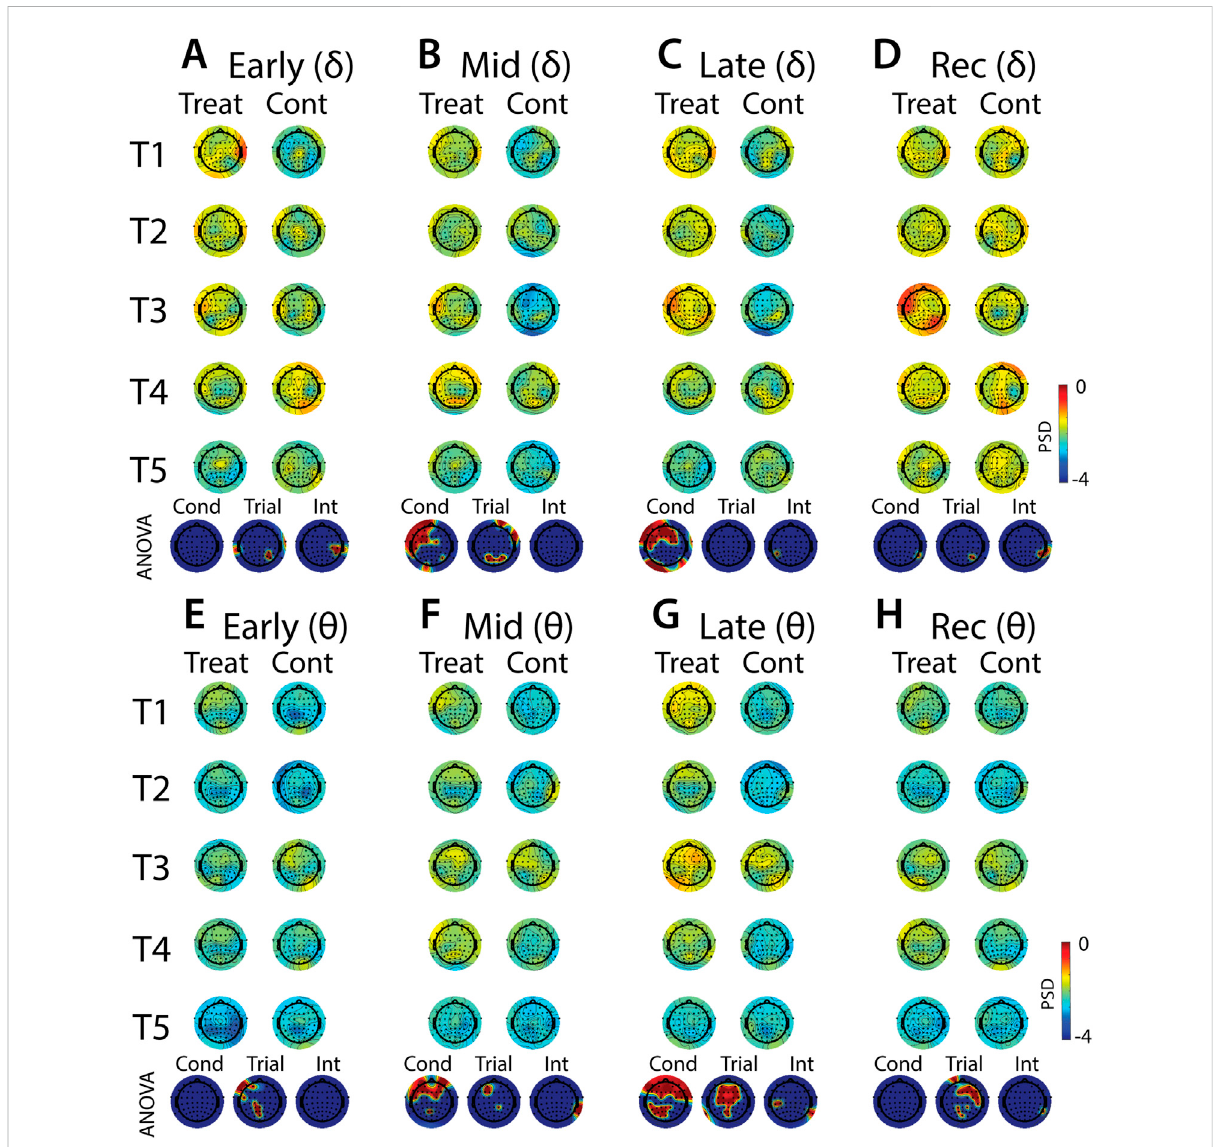
FIGURE 10 Effects of treatment and repeated trial exposure on stress-evoked oscillatory neural activity in delta and theta frequency bands. Topographic plotsineachpaneldepictevokedstresseffectsonoscillatoryneuralactivityinthedelta (A – D) andtheta (E – H) frequencybands.Topographicplotsin panels A – D and E – H respectively represent brain activity averaged across the early (65 – 94 s), mid (95 – 124 s), late (125 – 154 s) and recovery (155 – 190 s)periodsoftheimmersionperiod.Eachpanelcontainsseparatecolumnsofplotsforthetreatmentandcontrolconditions,witheach repetition trial (T1-T5) represented by each row. Condition (treatment, control) by trial (T1-T5) ANOVA results at each electrode are plotted at the base of each panel, with condition, trial and interaction effects depicted in separate topographic plots. Scalp regions overlaid in red indicate signi fi cant effects ( p null <